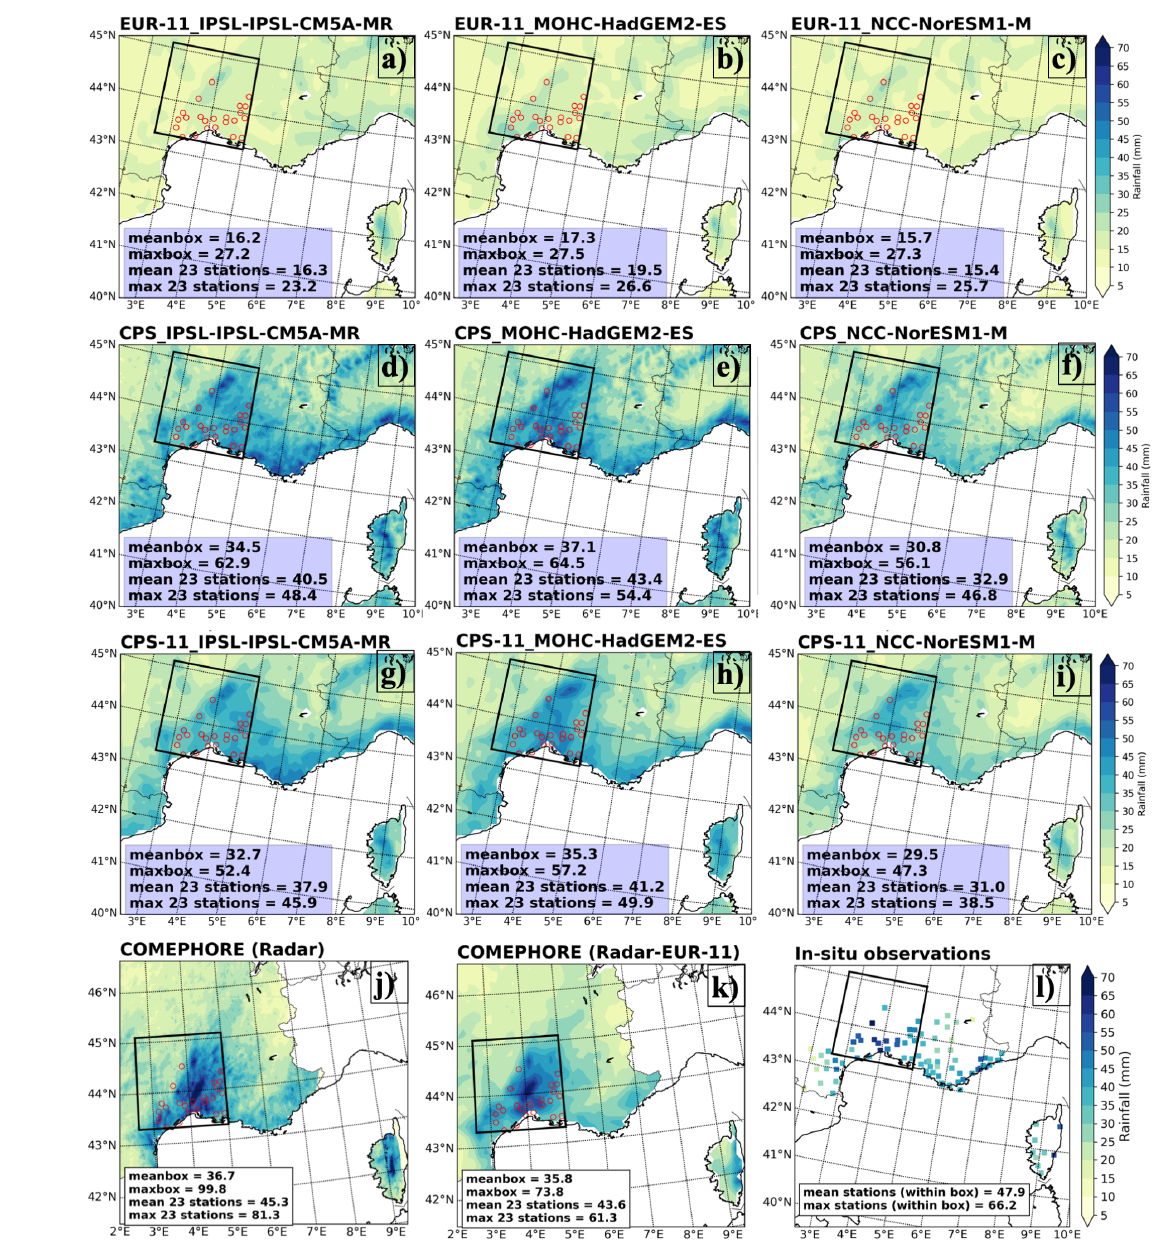
Figure 3. The autumn maximum 3h rainfall (Rx3hour) from EUR-11 (a–c) simulations (2001–2030), CPS (d–f) simulations (2001–2030), CPS-11 (g–i) , the COMEPHORE (j) dataset (1997–2007), upscaling COMEPHORE (k) , and in situ observations (l) (1998–2018); the red empty circles inside the Cévennes box from panels (a) to (k) denote 23 stations for which 3-hourly data are